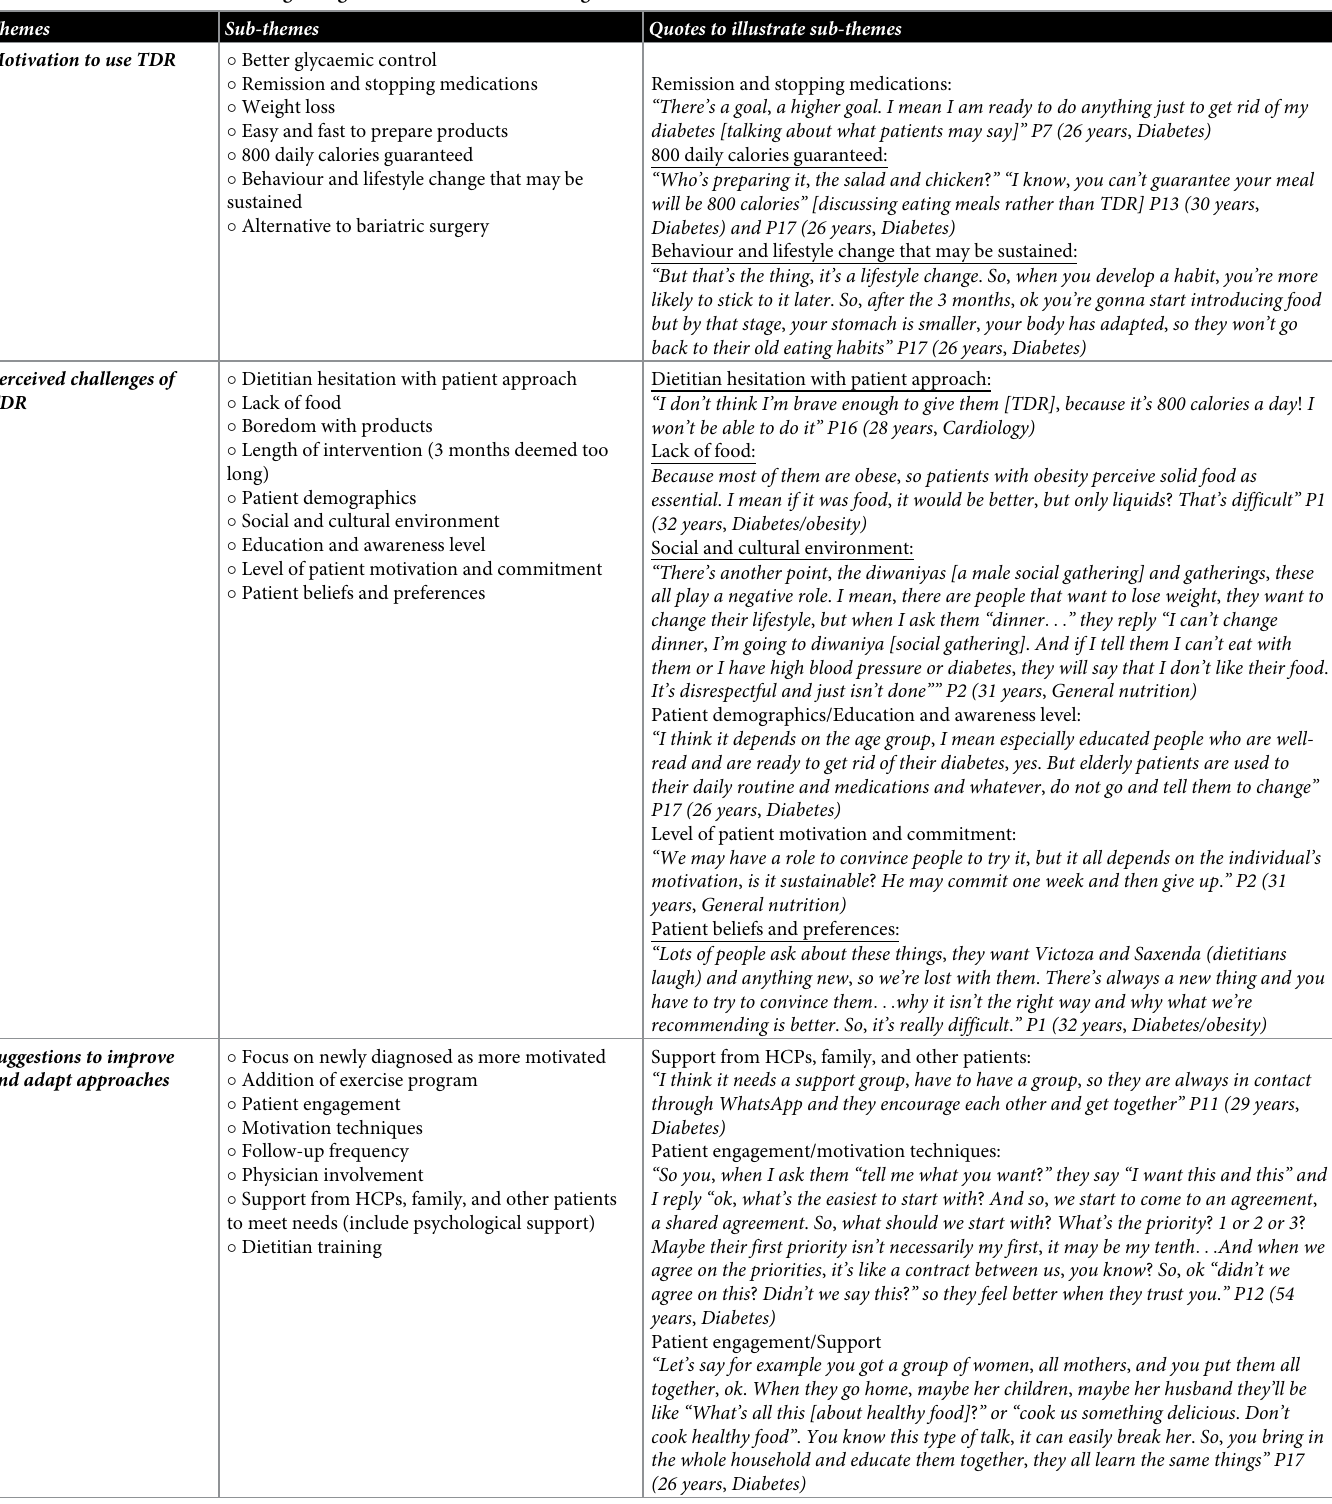
Table 1. Themes and sub-themes regarding diabetes remission and using